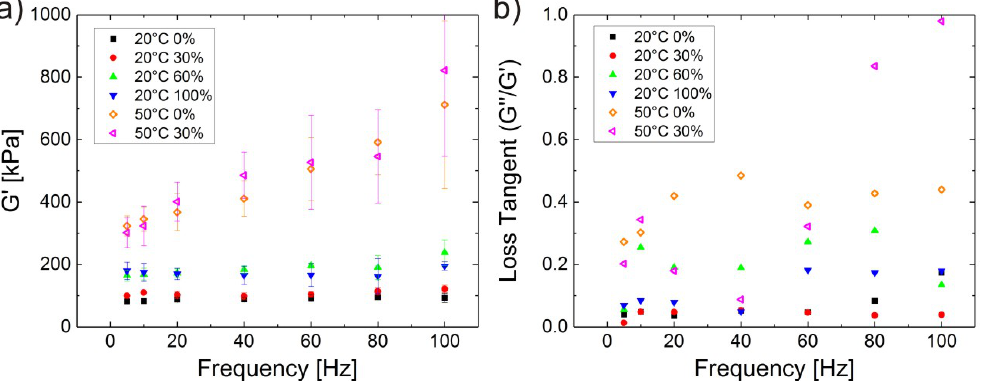
Figure 3. ( a ) Storage modulus G (cid:48) and ( b ) loss tangent G (cid:48)(cid:48) / G (cid:48) of P(NIPAM- co -AAc) microgels for various ethanol concentrations at 20 and 50 ◦ C at an indentation force of 2nN. The microgels were spin-coated from aqueous solutions onto gold surfaces. Taken from